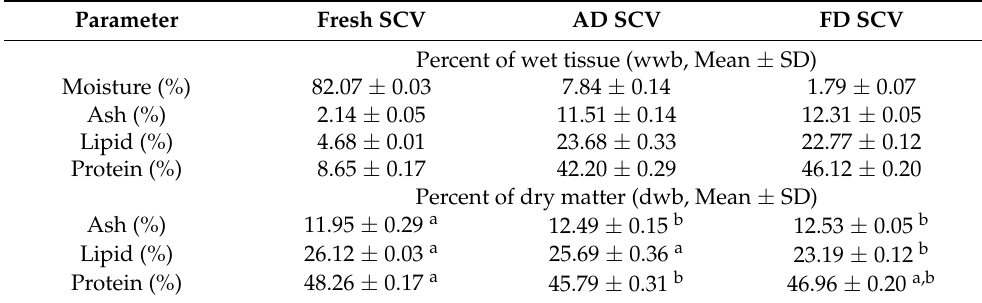
Table 1. Proximate composition of fresh, air-dried (AD SCV), and freeze-dried (FD SCV) sea cucumber viscera (wwb: wet weight basis, dwb: dry weight basis).